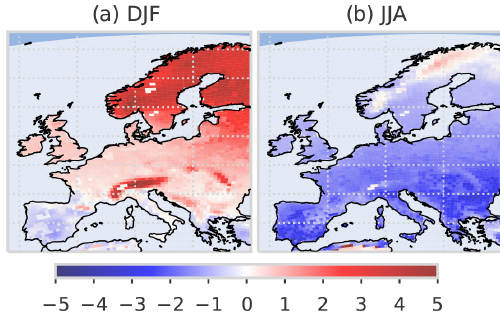
Figure 3. Mean differences in T s in K between CARBON and GRASS for the period 1986–2015 for (a) the winter season and (b) the summer season.